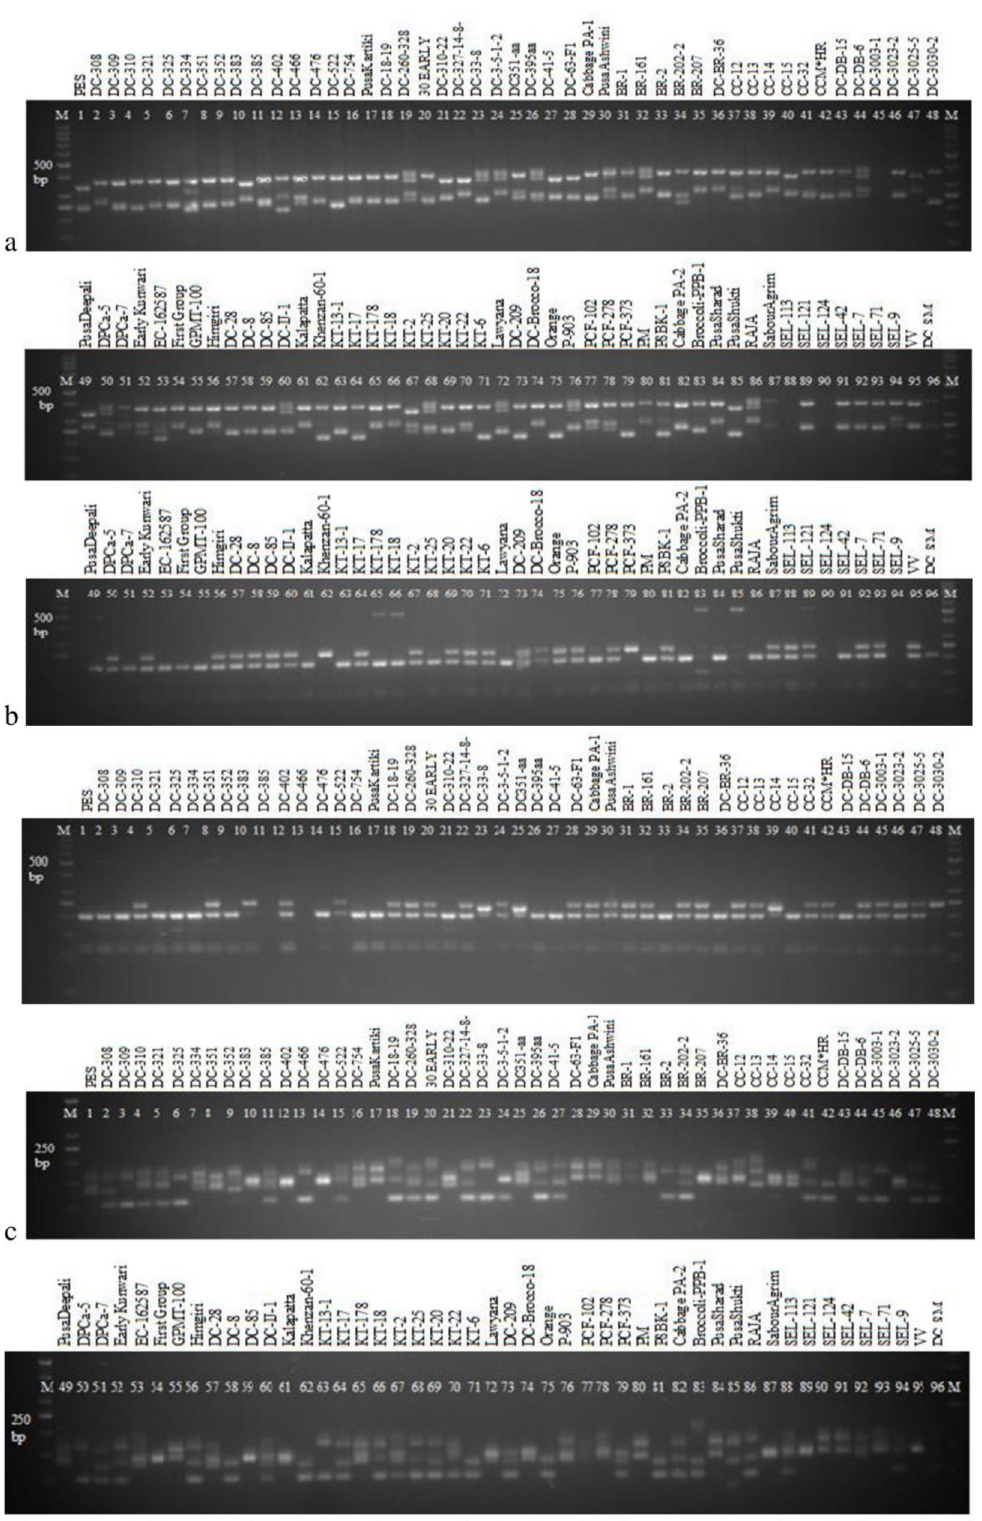
Fig 3. PCR amplification of genomic DNA of 96 genotypes of cauliflower and related crops with SSR markers. BoGMS0742 (a), BoGMS 0929 (b) and OI 10DO3 (c). M- Marker.